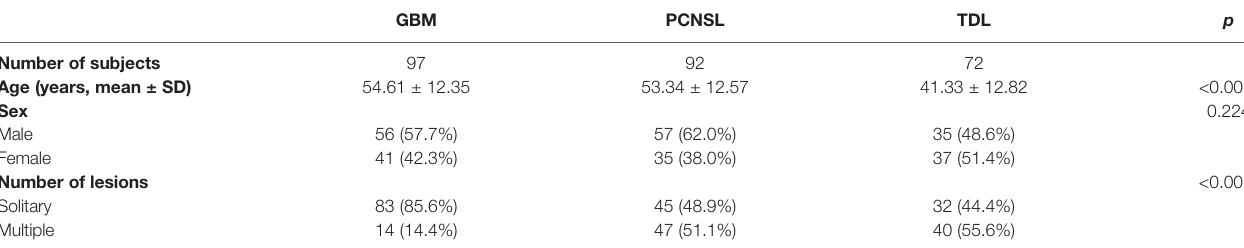
TABLE 1 | Clinical characteristics of subjects.